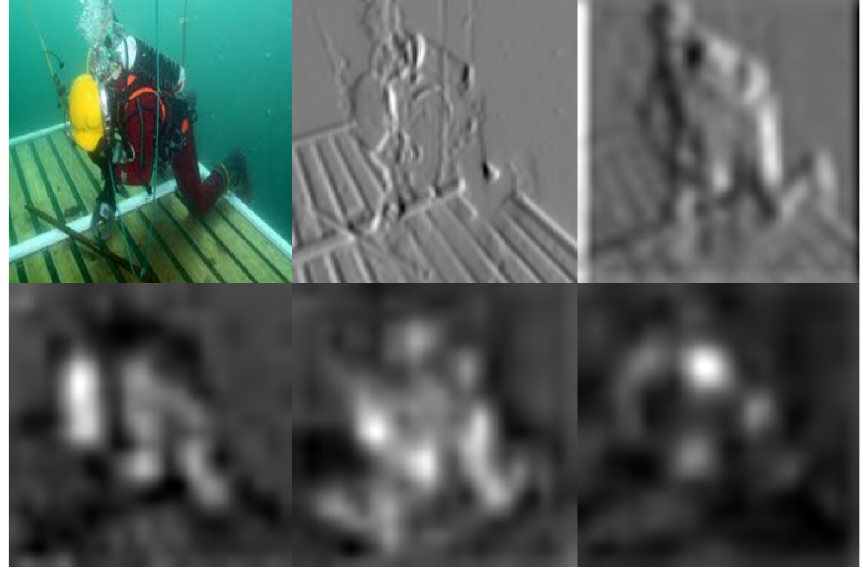
Figure 10. Diver wrongly classified as an UUV (from top right to bottom left): source image, processed images in grey for the following layer outputs of DLNN: conv1, conv2, conv3, conv4 and conv5. The AlexNet trained by SGDM obtained the best